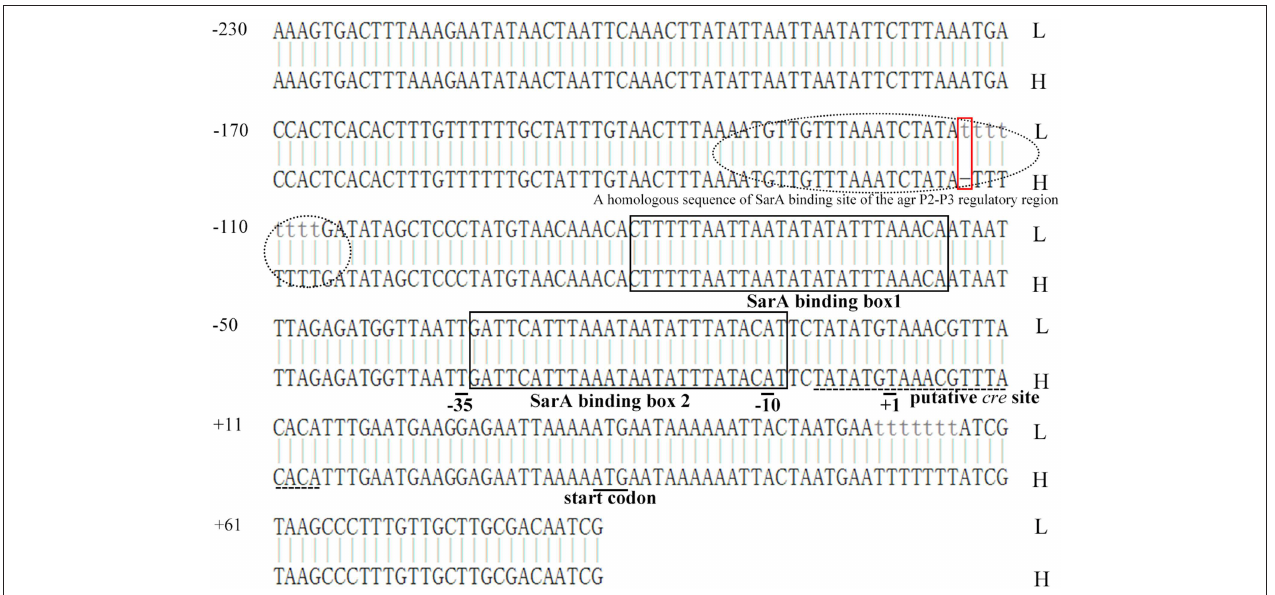
FIGURE 4 | Alignment of tst promoters in tst gene high- and low-expression isolates. H, tst high-expression strains; L, tst low-expression strains. Two isolates (H-LS1956 and H-SJ0951) with the tst gene high expression have a base T deletion in the promoter region (nt-114, red rectangular box). This region is AT-rich and the homologous sequence of the agr P2-P3 regulatory site SarA binding (dotted oval) ( Chan and Foster, 1998b), and is located in the upstream of SarA binding box 1/2 (black rectangular boxes) and a putative catabolite-responsive element ( cre ) region (dashed line) ( Seidl et al.,